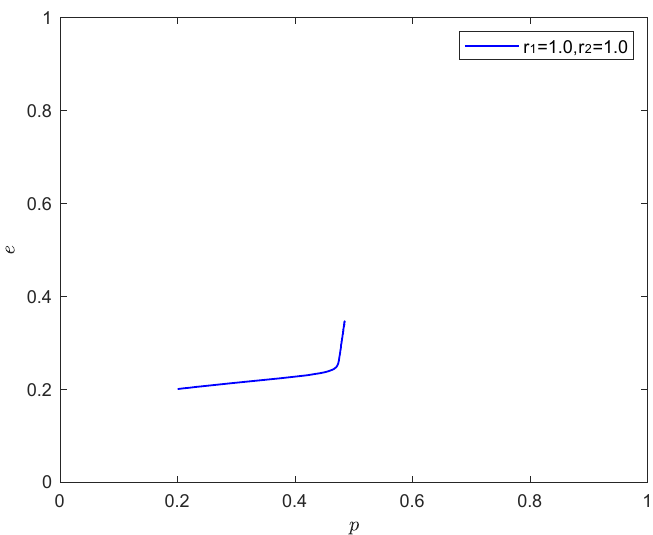
Figure 3. Evolution of game strategy in (rational, rational) state.